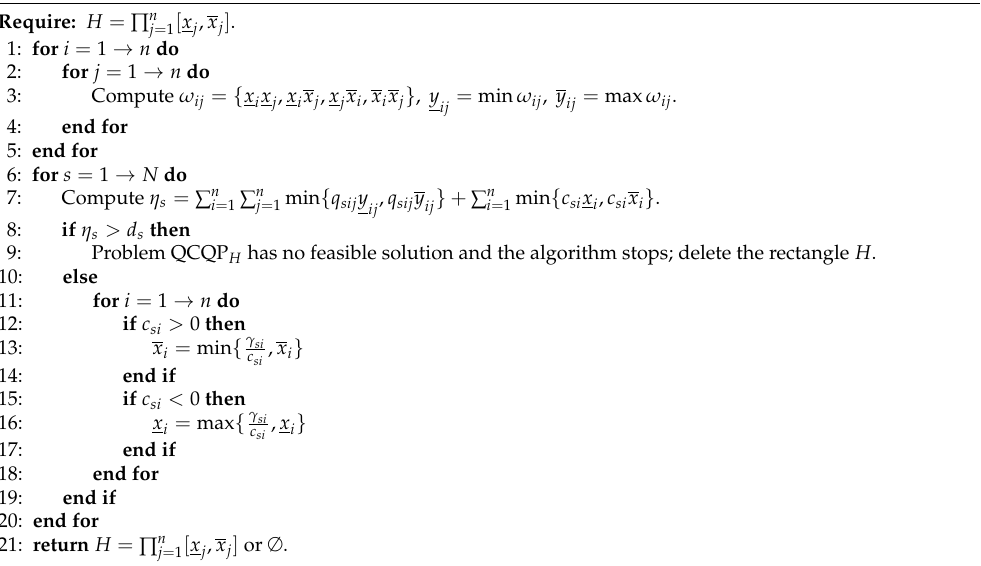
Algorithm 2 Rectangle-Reduction Technique based on Quadratic